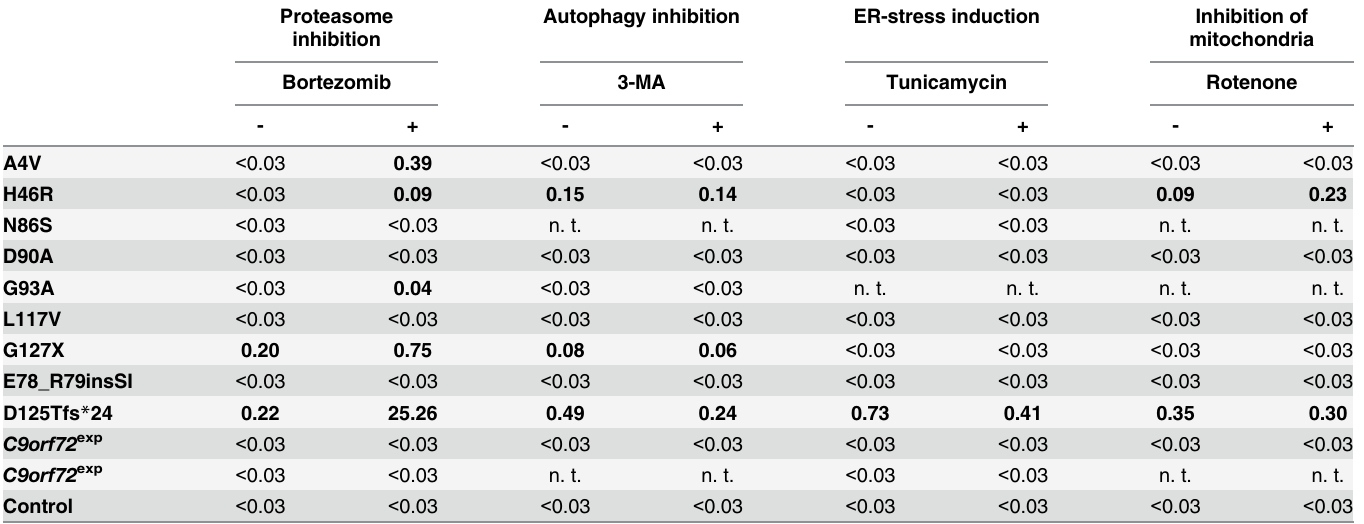
Table 1. Detergent-resistant SOD1 aggregates in fibroblast